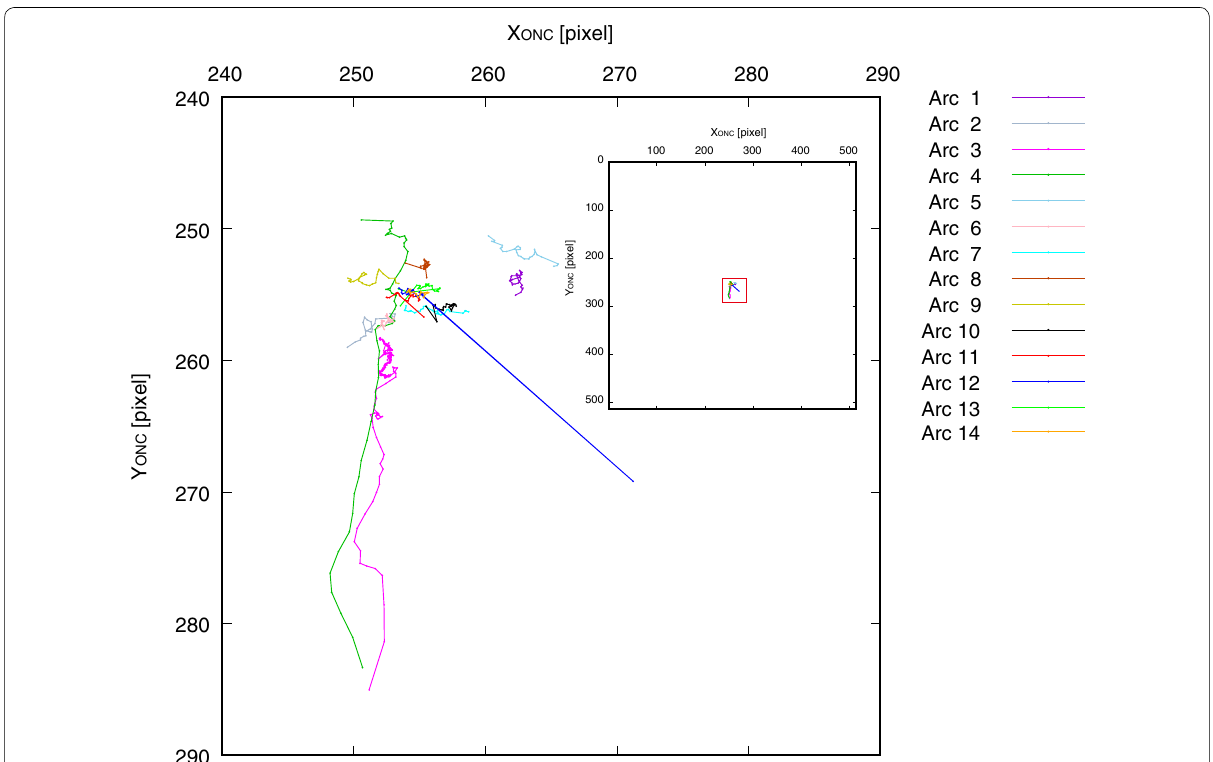
Fig. 2 Temporal change in image‑tracking‑data coordinate for the duration of each arc. Arc numbers are listed in Table